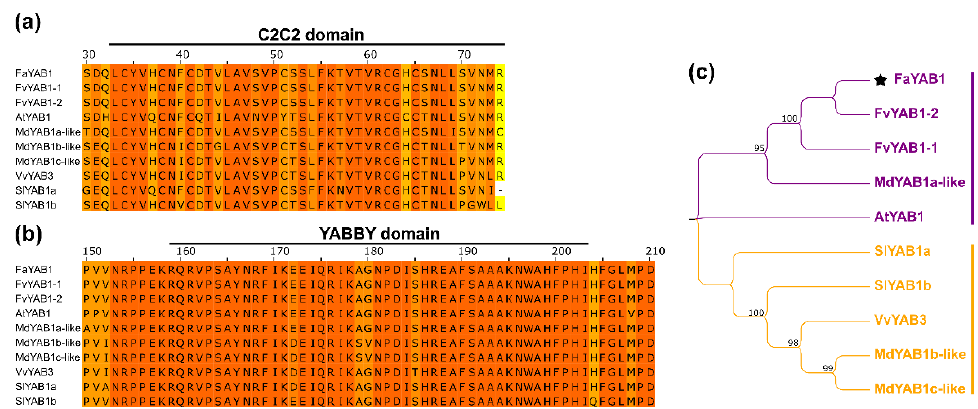
Figure 3. Characterization of Fragaria × ananassa YABBY1 (FaYAB1) protein and the comparison with their orthologs. ( a ) Multiple alignment of C2C2 domain, ( b ) YABBY domain, and ( c ) phylogenetic analysis for FaYAB1 protein and their orthologs in Fragaria vesca , Arabidopsis thaliana , Malus × domestica , Vitis vinifera, and Solanum lycopersicum . Orange and yellow colors in the multiple alignment indicate higher and lower conservation of amino acid residues, respectively. The unrooted phylogenetic tree was performed using full-length YAB protein sequences. FaYAB1 protein is indicated by a black star. ‘I’ and ‘II’ indicate the group number. Nodes with bootstrap values > 70% are labelled. C2C2, C2C2 zinc-finger domain. FaYAB1, F. × ananassa YAB1; FvYAB1-1, F. vesca YAB1-